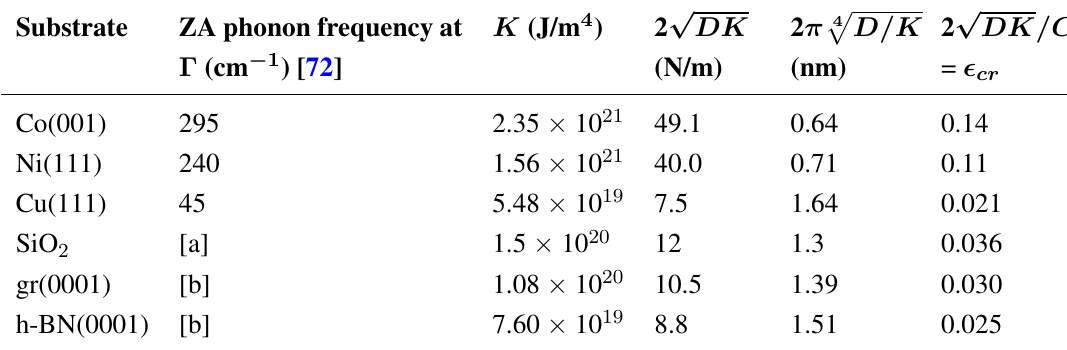
Table 4. Force constant of the the graphene–substrate interaction K and related parameters (see text). The values used for the flexural rigidity D and the stiffness constant C of graphene are 1.6 eV and 350 N/m,